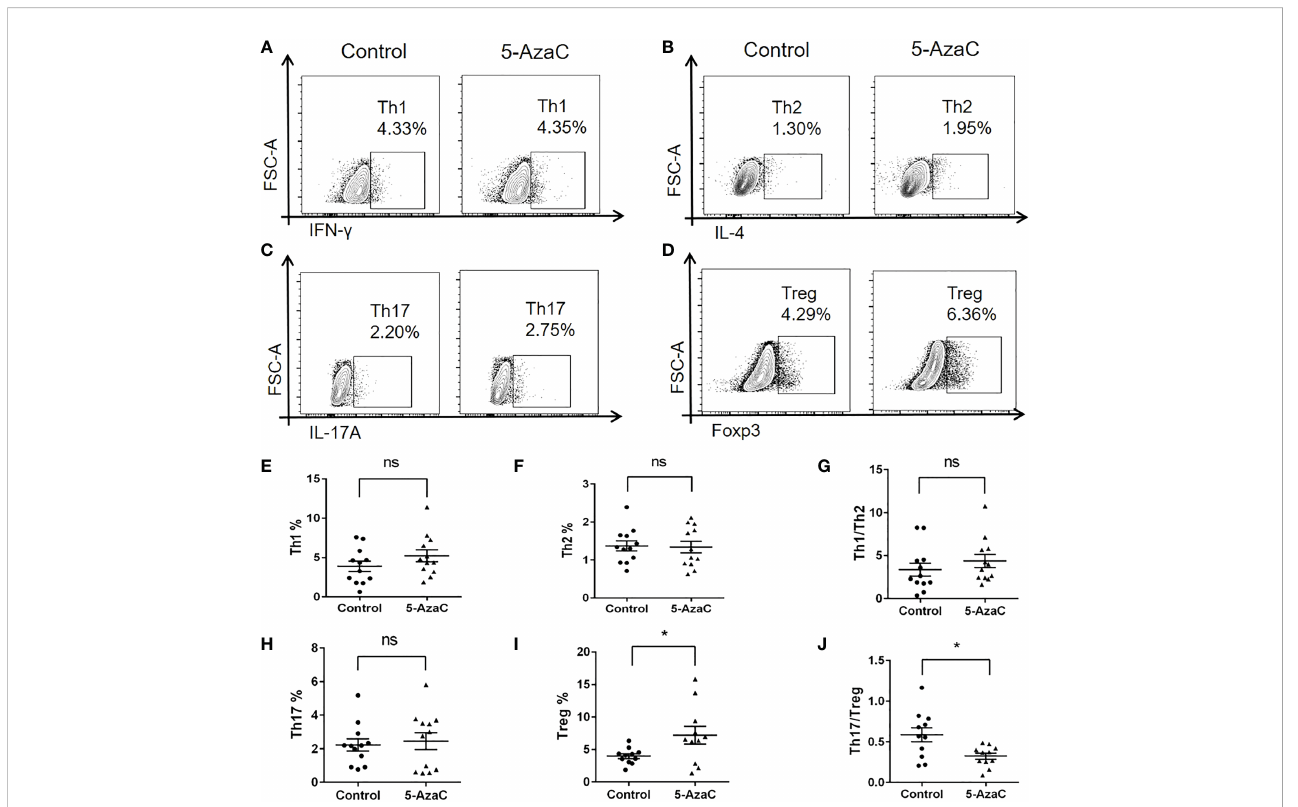
FIGURE 8 In-vitro effects of 5-AzaC on subsets of CD4 + T cells from RA patients by multiparameter fl ow cytometry. The differentiation of CD4 + T cells isolated from peripheral blood of RA patients was assessed after stimulation with PHA and IL-2 in the presence or absence of 5-AzaC (2 m M). (A, E) Representative fl ow-cytometric histogram and quantitative analysis of the Th1 subset (CD4 + IFN- g + ). (B, F) Representative fl ow-cytometric histogram and quantitative analysis of the Th2 subset (CD4 + IL-4 + ). (C, H) Representative fl ow-cytometric histogram and quantitative analysis of the Th17 subset (CD4 + IL-17A + ). (D, I) Representative fl ow-cytometric histogram and quantitative analysis of the Treg subset (CD4 + Foxp3 + ). (G) The Th1/Th2 ratio. (J) The Th17/Treg ratio. Each dot represents one individual and data are the mean ± SD for groups of 12 samples *P < 0.05. ns, not signi fi